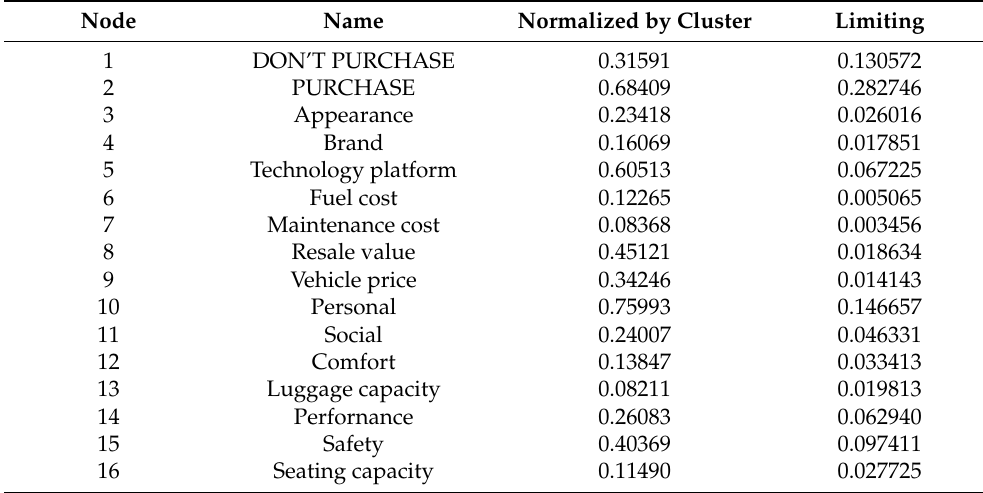
Table 16. Results of Purchase intention of Interviewee